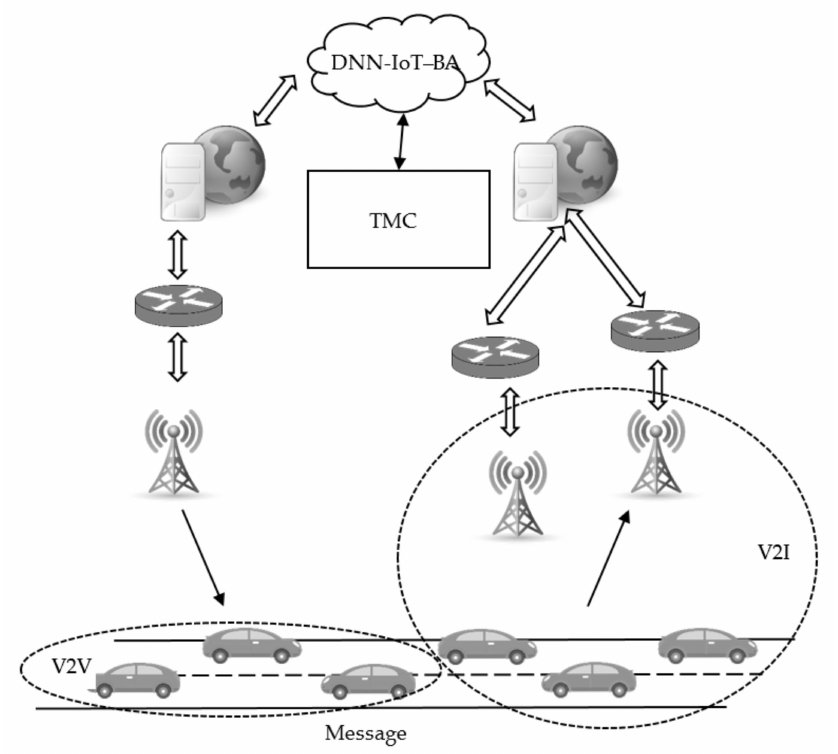
Figure 1. Vehicular Adhoc Networks (VANETs)